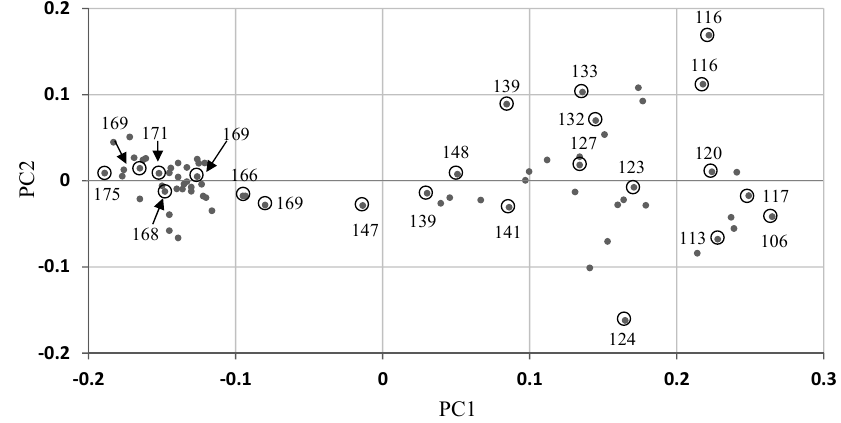
Figure 7. Uploading the total absorption area into the score plot of partial least squares (PLS) of the Cl model using the slope method. Numbers next to gray circles represent the total area of water absorption.